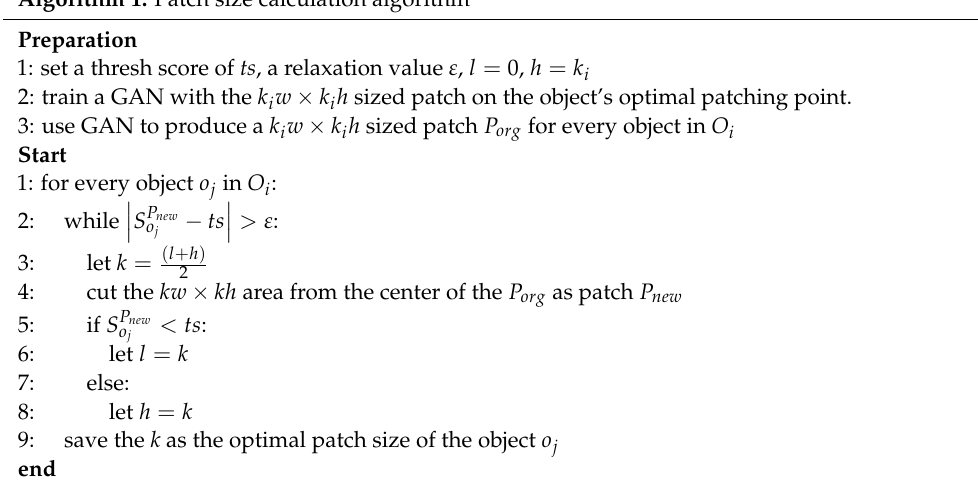
Algorithm 1: Patch size calculation